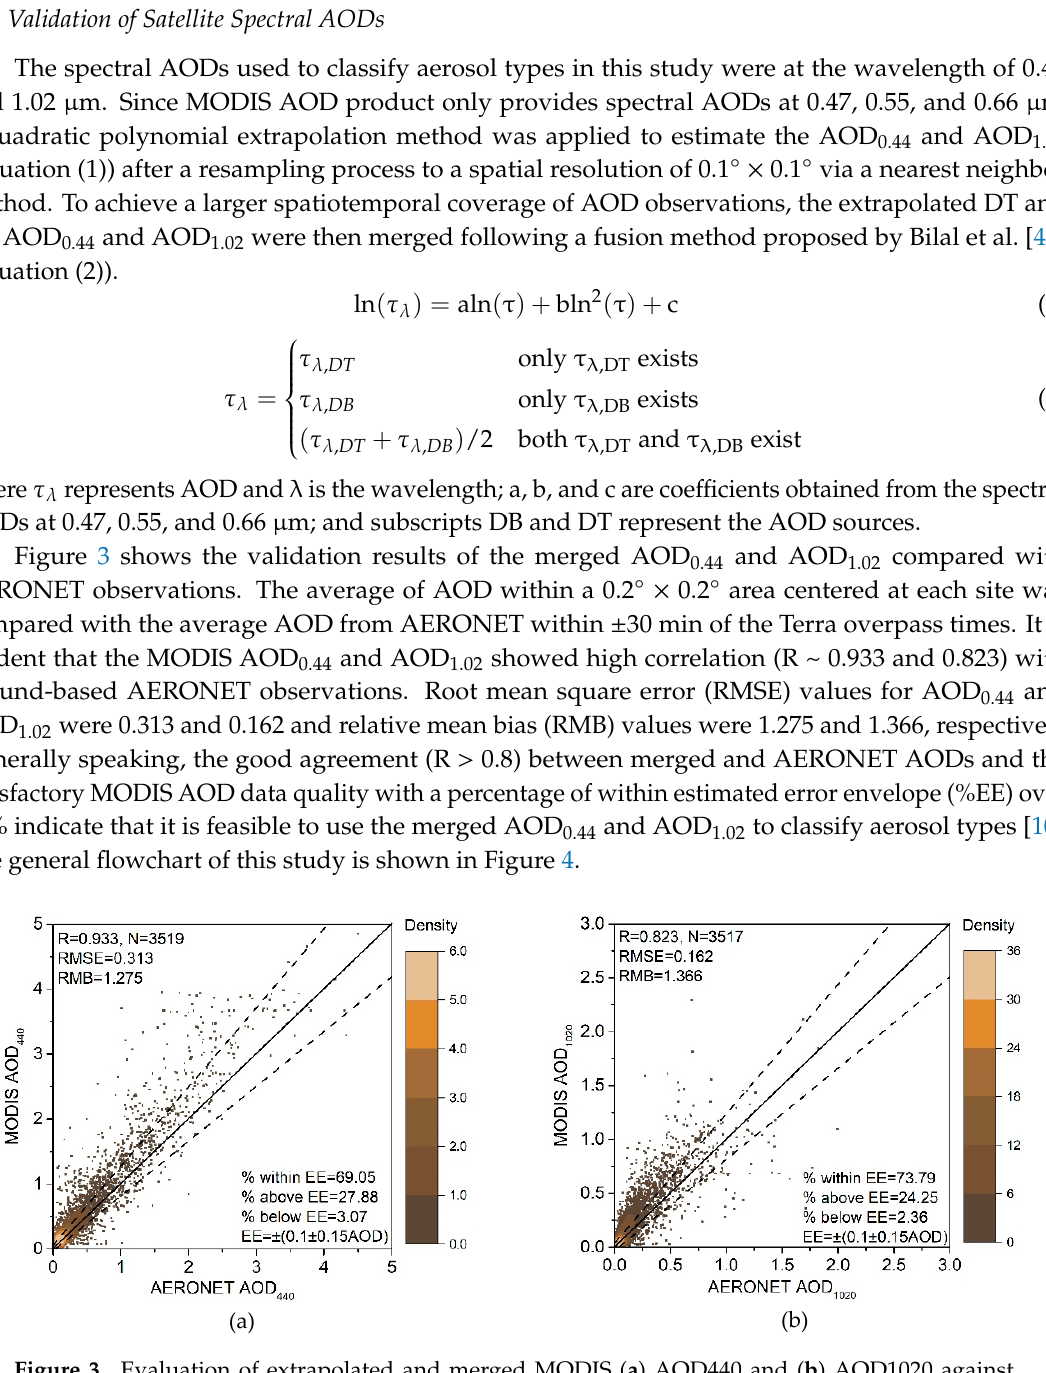
Figure 3. Evaluation of extrapolated and merged MODIS ( a ) AOD440 and ( b ) AOD1020 against the AERONET observations. The dashed lines are the EE lines and the solid line is 1:1 line. R, N, RMSE, and RMB represent the correlation coefficient, number of observations, root mean square error, and relative mean bias and EE denotes the expected error.